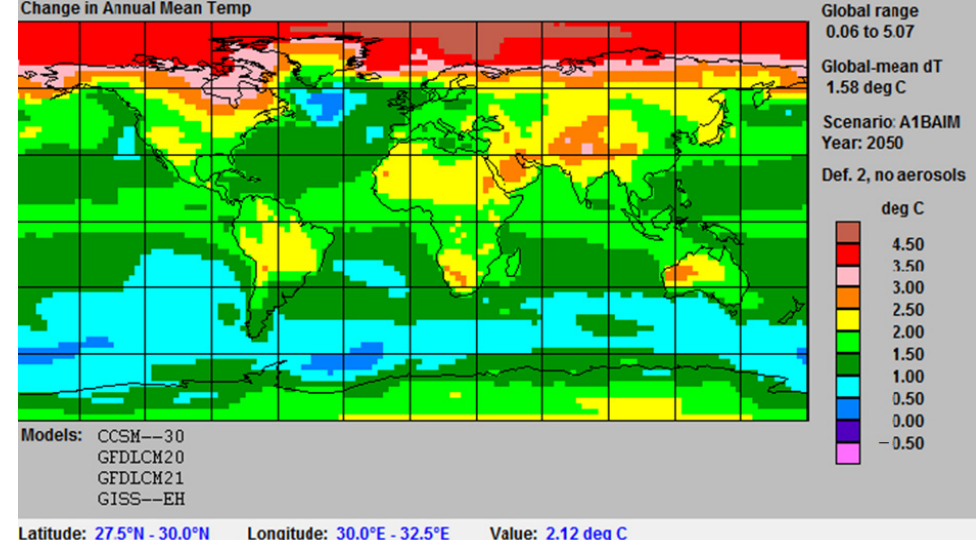
Figure 3. Change in annual mean temperature in 2050 at the regional level at latitude 27.5 ◦ N–30.0 ◦ N and longitude 30.0 ◦ E–32.5 ◦ E.